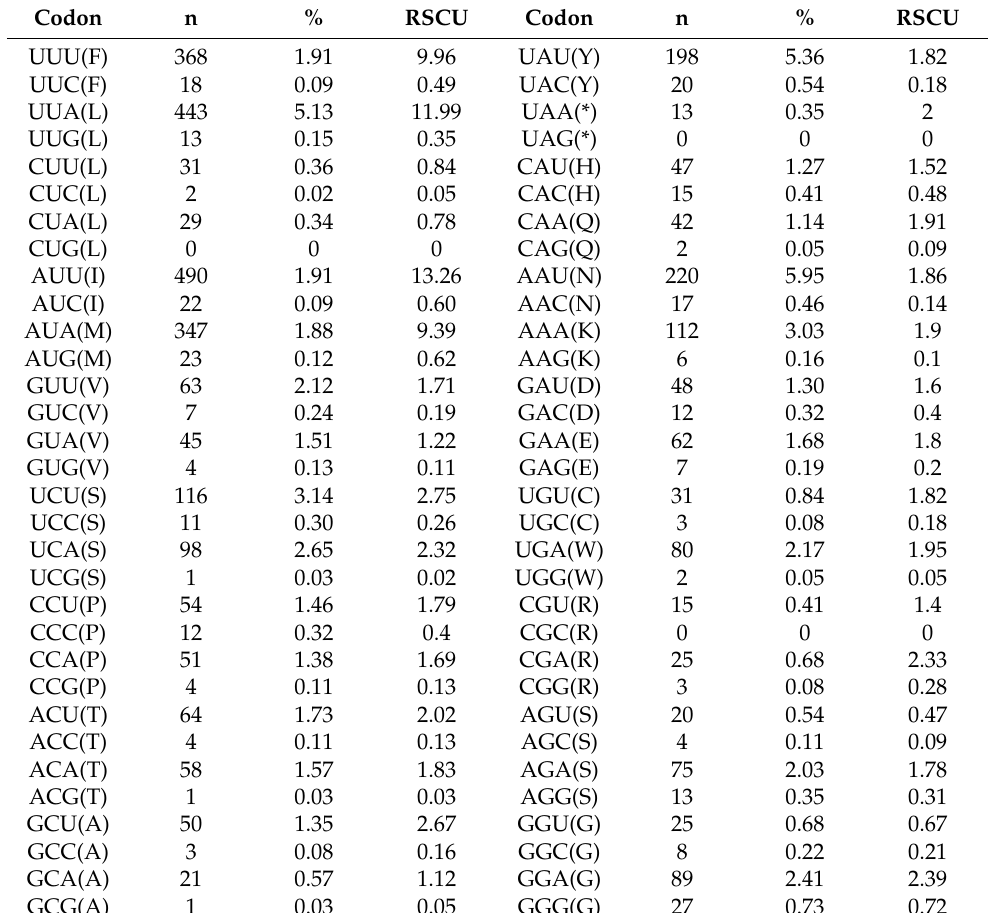
Table 3. Codon usage of Tapinoma ibericum mitogenome protein coding genes. A total of 3695 codons were analyzed. RSCU: relative synonymous codon usage. * = termination